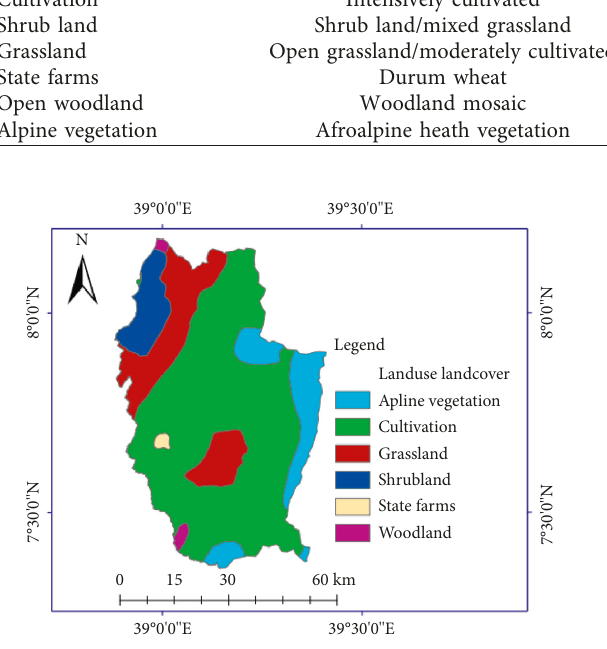
Figure 3: Ketar River watershed land use/land cover. Table 4: Slope class in Ketar River watershed.